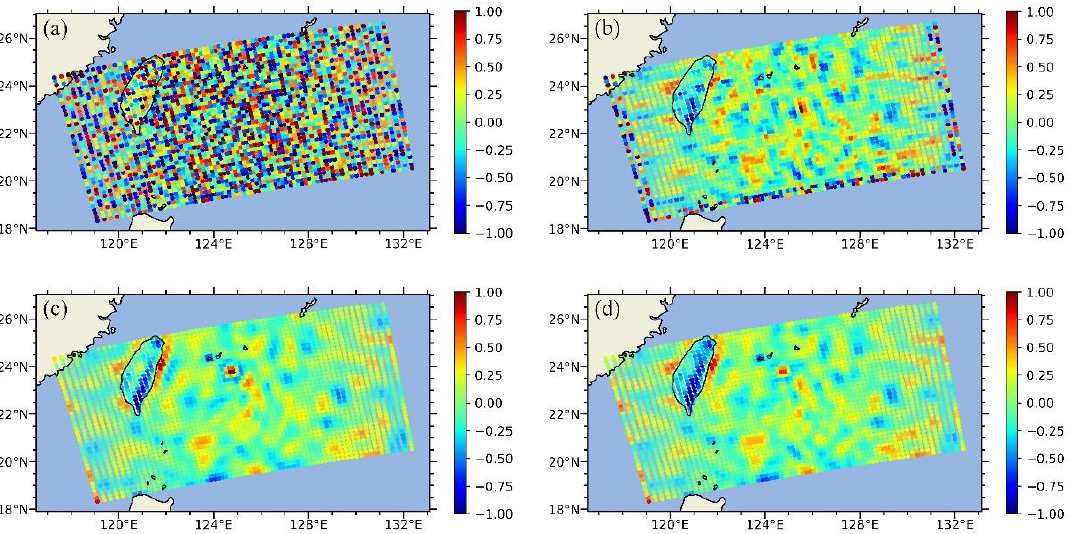
Figure 9. Brightness temperature differences between ( a ) 2.2° simulations and truth value (Figure 8a,b); ( b ) brightness temperature differences between results resampled by BGI and truth value (Figure 8b,c); ( c ) brightness temperature differences between results resampled by AAPP and truth value (Figure 8b,d); ( d ) brightness temperature differences between results resampled by modified AAPP and truth (Figure 8b,e). The unit of brightness temperature differences is